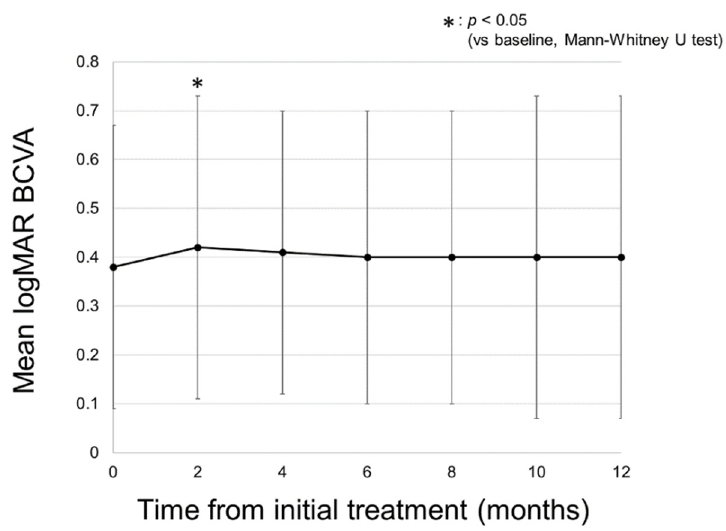
Figure 2. Changes in the mean logarithm of the minimal angle resolution (logMAR) best-corrected visual acuity (BCVA) in all patients. The mean BCVA in all patients was 0.38 ± 0.29 at baseline and was 0.42 ± 0.31, 0.41 ± 0.29, 0.40 ± 0.30, 0.40 ± 0.33, and 0.40 ± 0.33 at 2, 4, 6, 8, 10, and 12 months, respectively. The mean logMAR BCVA was consistent at 12 months from baseline ( p = 0.55).